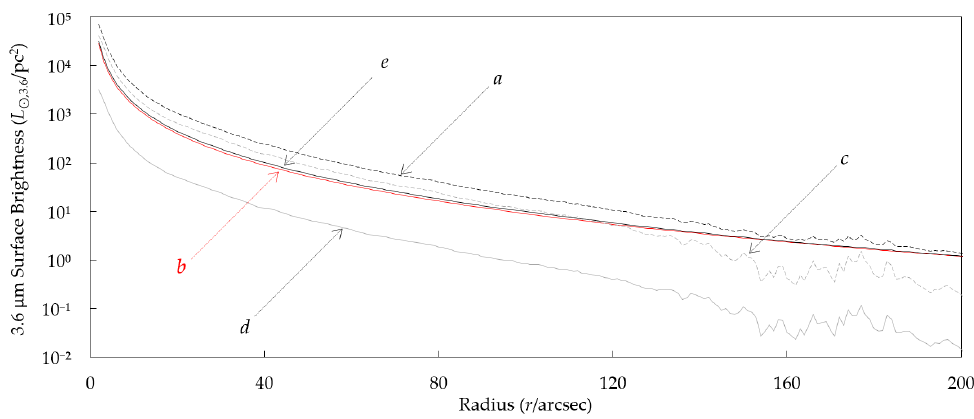
Figure A3. Inclination correction for 90% bulge light-dominated 90 ◦ edge-on galaxy NGC7814. ( a ) Clean but uncorrected-for-inclination surface brightness profile from S4G; ( b ) S é rsic bulge with model parameters from S4G P4; ( c ) uncorrected disk profile, the di ff erence between ( a ) and ( b ); ( d ) inclination corrected disk, correction factor 0.078; ( e ) inclination corrected galaxy profile, the sum of the bulge ( b ), and inclination-corrected disk ( d